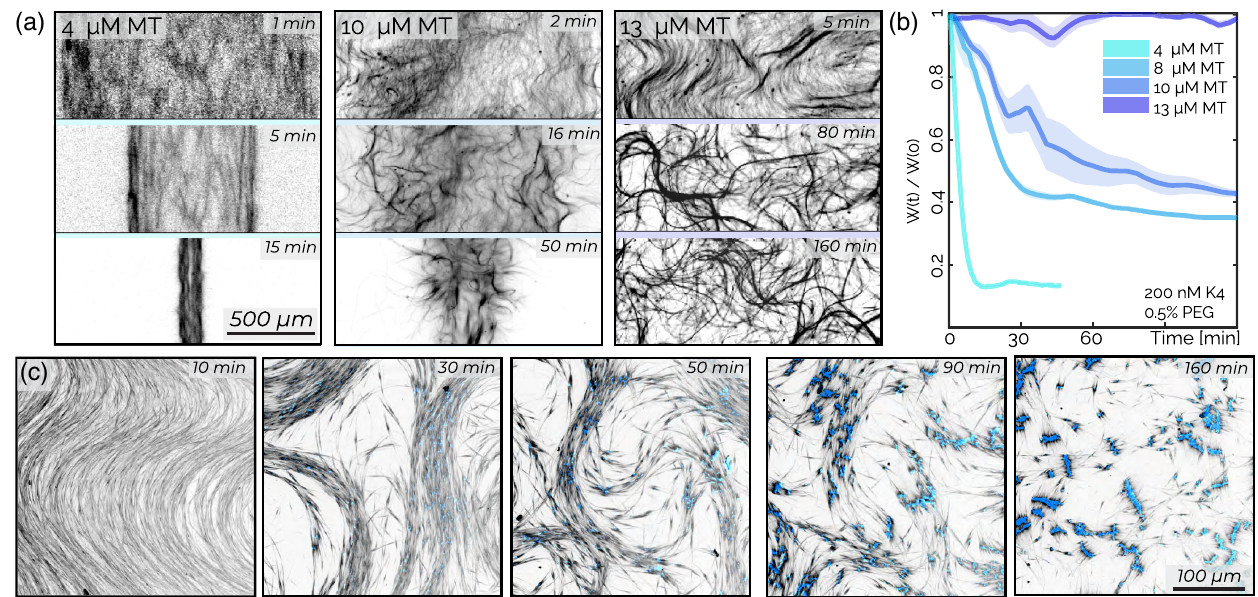
FIG. 8. Extensile fluid: a bundling-induced transition from contraction to extensile gels. (a) The evolution of the shear-aligned microtubule network depends on filament concentrations. Samples have 0.5% PEG, 200 nM kinesin. (b) The average microtubule network width W ð t Þ , normalized by the initial width W ð 0 Þ , decreases over time, with lower microtubule densities contracting faster. The shaded region indicates the standard deviation from data taken at five nonoverlapping positions over the long axis of the chamber. (c) Extensile instability leads to the formation of a bilayer structure. This sample chamber is 30 μ m thick; this sample contains 100 nM kinesin (blue), 80 μ M tubulin (black), and 0.1%